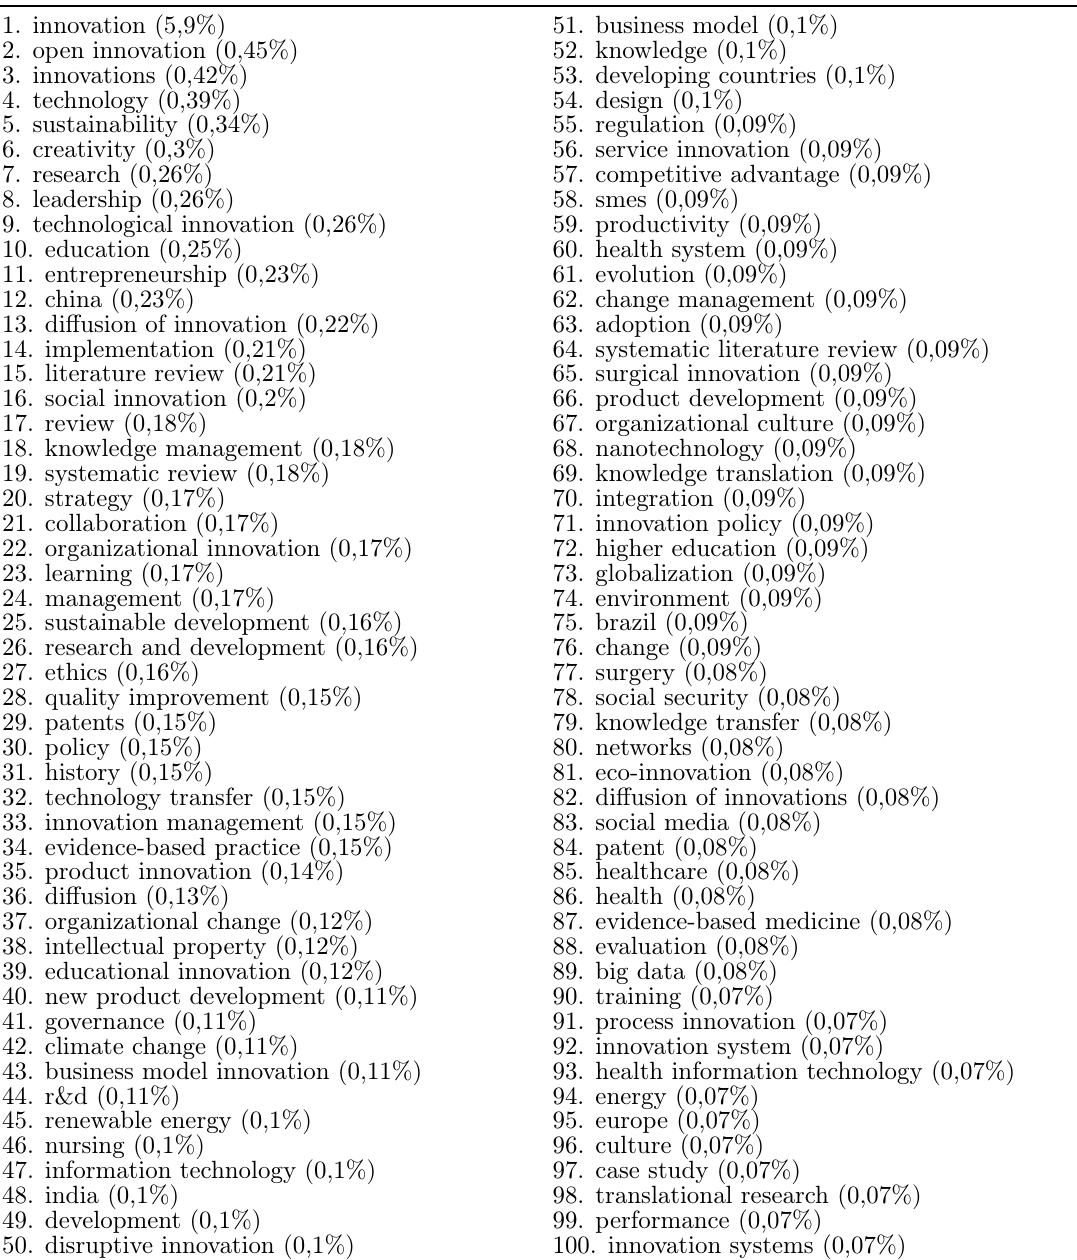
Table A.1. List of the first most used 100 “Author keywords” out of 21159 keywords extracted from 5166 papers. “Index Keywords” were not used in this